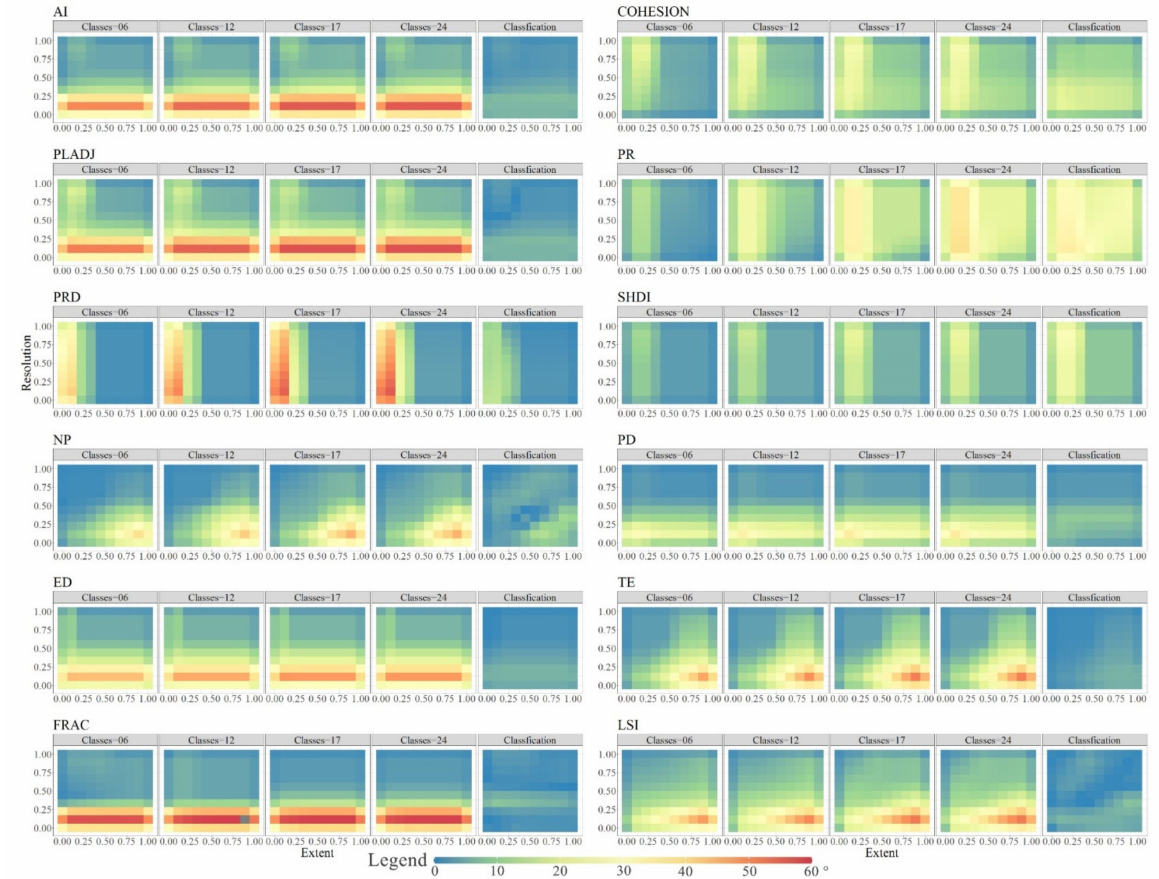
Figure 8. The scaling-sensitive maps of 12 landscape